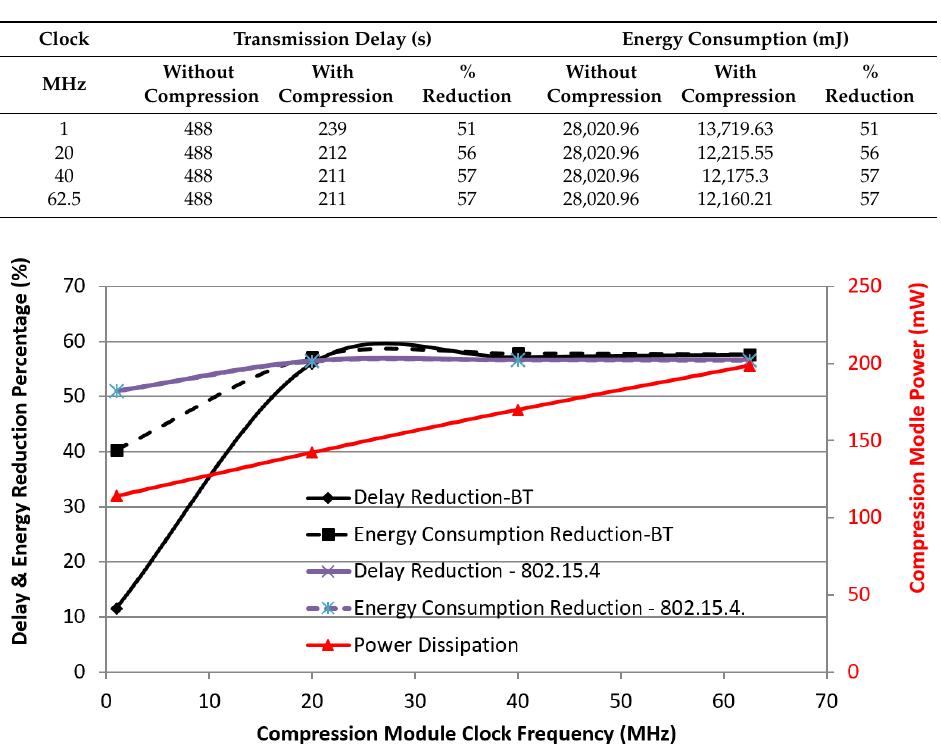
Table 7. Energy and delay reduction for ECG_UoP using shimmer 802.15.4 nodes.